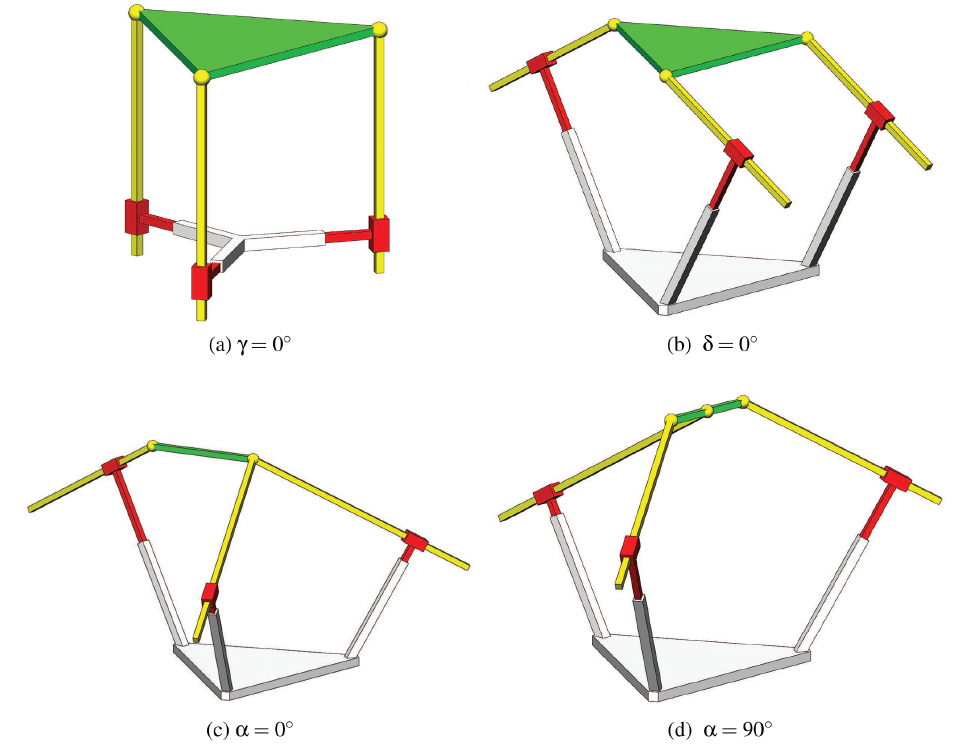
Figure 6. Four singular shapes of 3-PPS parallel kinematics machine.